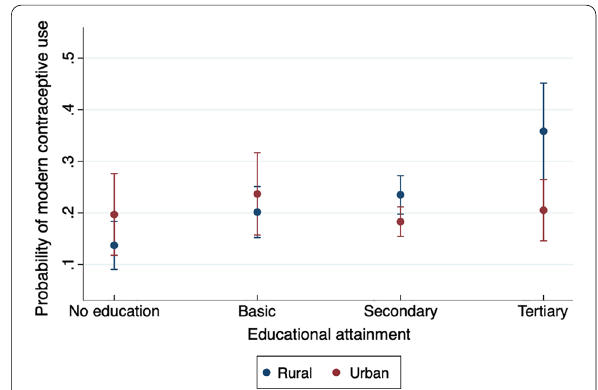
Fig. 3 Predictive margins of interaction between educational attainment and urban–rural residence with 95% confidence